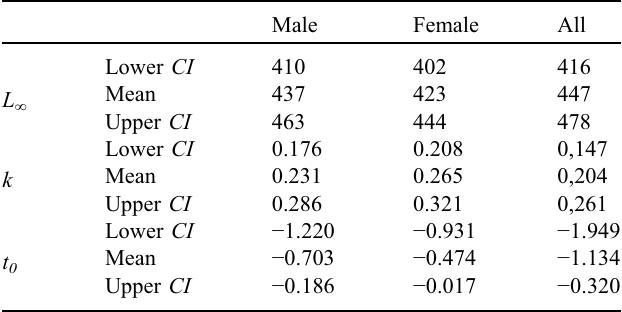
Table 5. Von Bertalanffy ’ s growth parameters and their respective con fi dence intervals ( CI = 0.05) for Pagrus pagrus fi shed off southern Brazil.